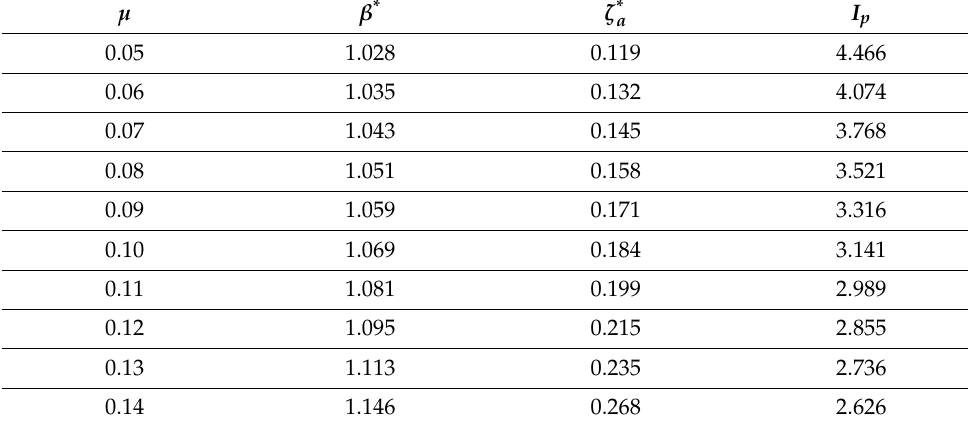
Table 1. The optimum parameters that minimize I p defined by Equation (20). µ β